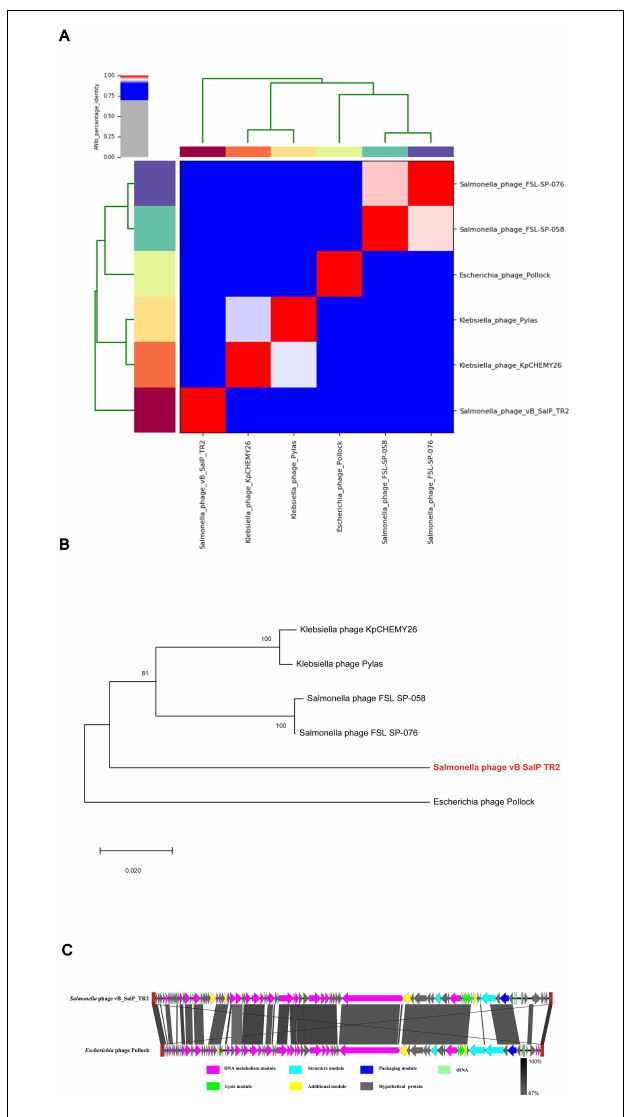
FIGURE 3 | Analysis of Salmonella phage vB_SalP_TR2 genome. (A) Heatmap of the average nucleotide identity (ANI) values among vB_SalP_TR2 and five related phages within Itachcavirus genus. ANIb tool in the pyani package is used. ANI values ranging from 0 (0%) to 1 (100%) were generated according to a matrix of percentage identity. (B) Phylogenetic tree of the major capsid protein sequences showing the phylogenetic position of phage vB_SalP_TR2 (in red and bold) within the Itachcavirus genus. The phylogenetic tree was generated in MEGA-X (v.10.0.5) using neighbor-joining method with p -distance values and bootstrap replicate of 1,000. Consensus support (%) > 50% is marked at each node. Scale bar represents 0.02 substitutions. (C) Genomic comparison of vB_SalP_TR2 and Escherichia phage Pollock generated using Easyfig. Genes with different functions